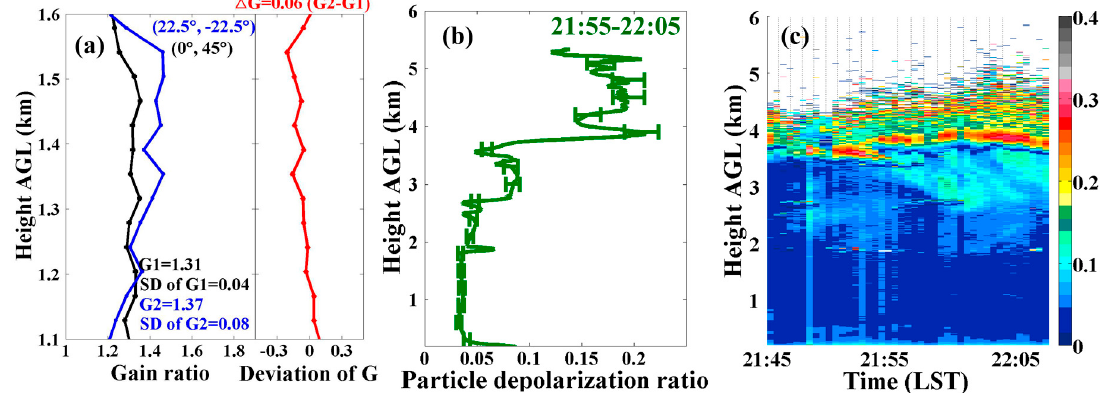
Figure 10. ( a ) Gain ratio determined during TIPEX III 2013 in Litang; ( b ) Profile of particle depolarization ratio (dark green line) with error bar (horizontal line) and ( c ) temporal development of particle depolarization ratio measured on 28 July 2013 in Litang.